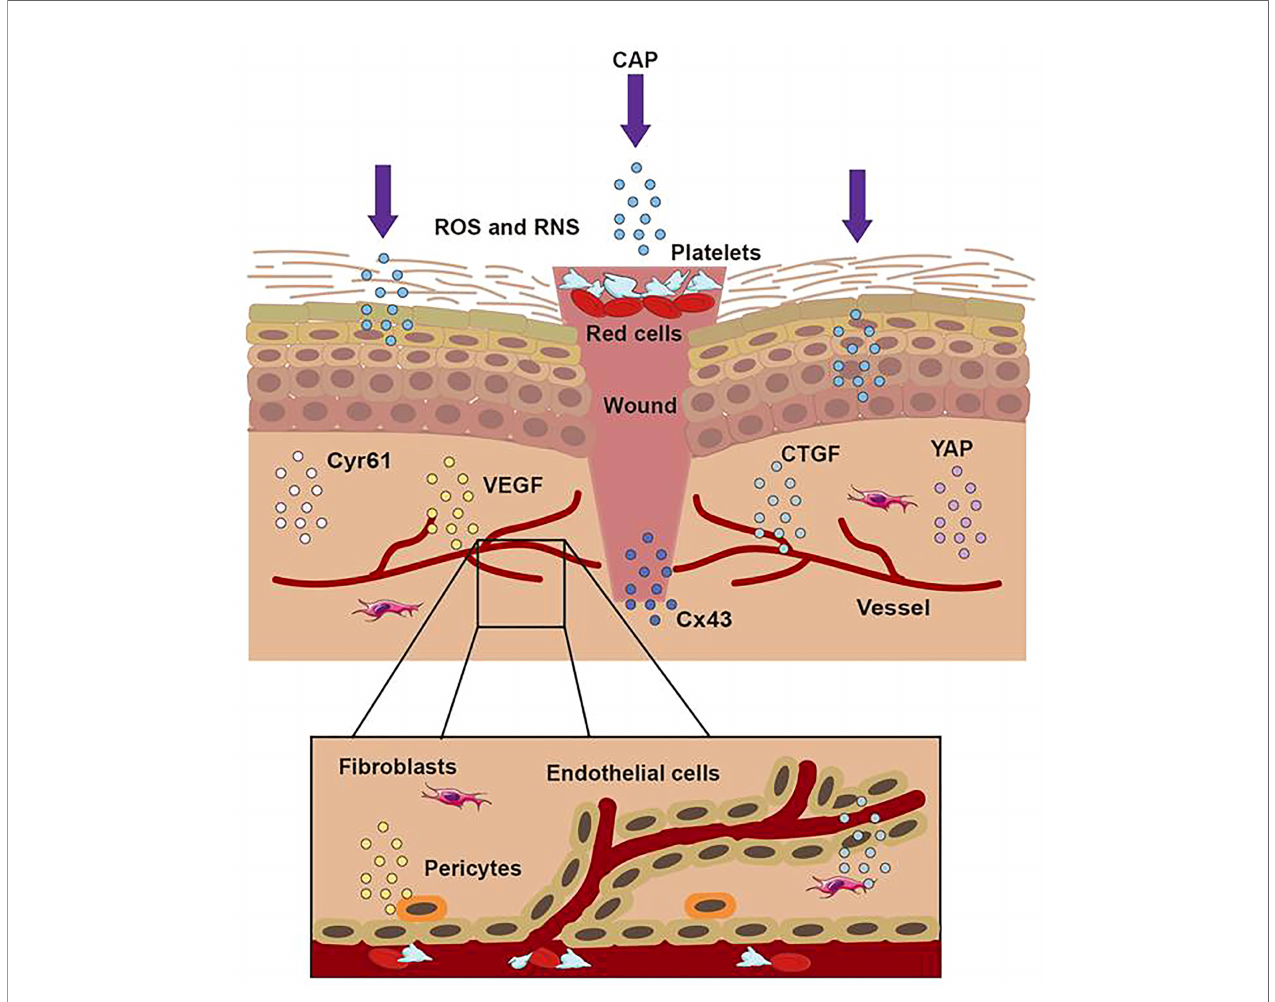
FIGURE 5 | The treatment of CAP on wound. When the skin was hurt, the fi rst step was to form a blood scab to protect the wound. CAP could accomplish wound healing through short-lived and long-lived ROS and RNS. CAP could promote the formation of new blood vessels, strengthen the release of CTGF and VEGF, activate the activation of the YAP pathway, and upregulate the expression of Cx43 and